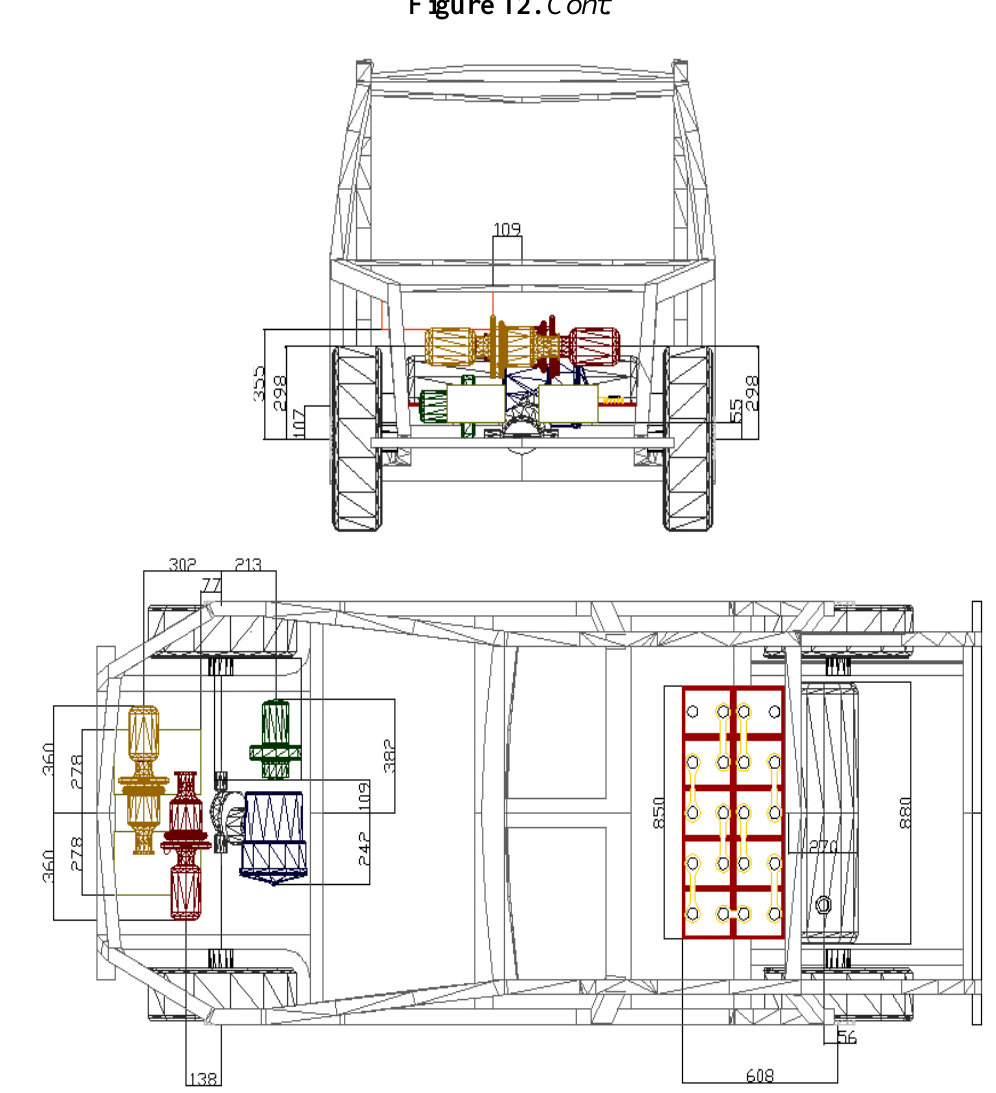
Figure 13. Weight distribution in the LETHE © Sedan configuration.